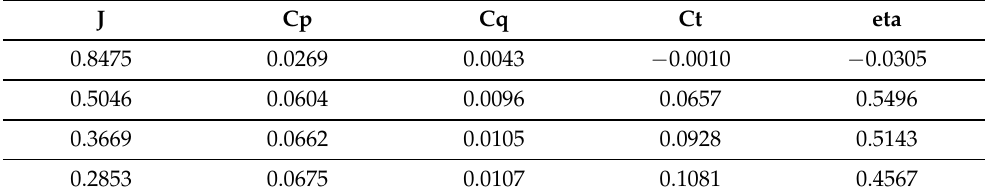
Table A7. APC 14 × 12 propeller wind tunnel processed